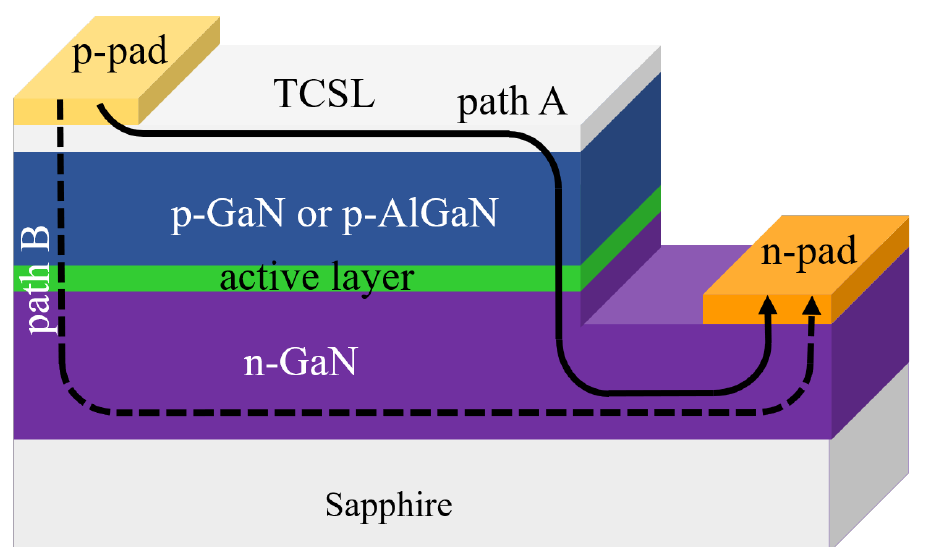
Figure 6. Current flow through path A (solid line) and path B (dashed line) in a typical GaN-based